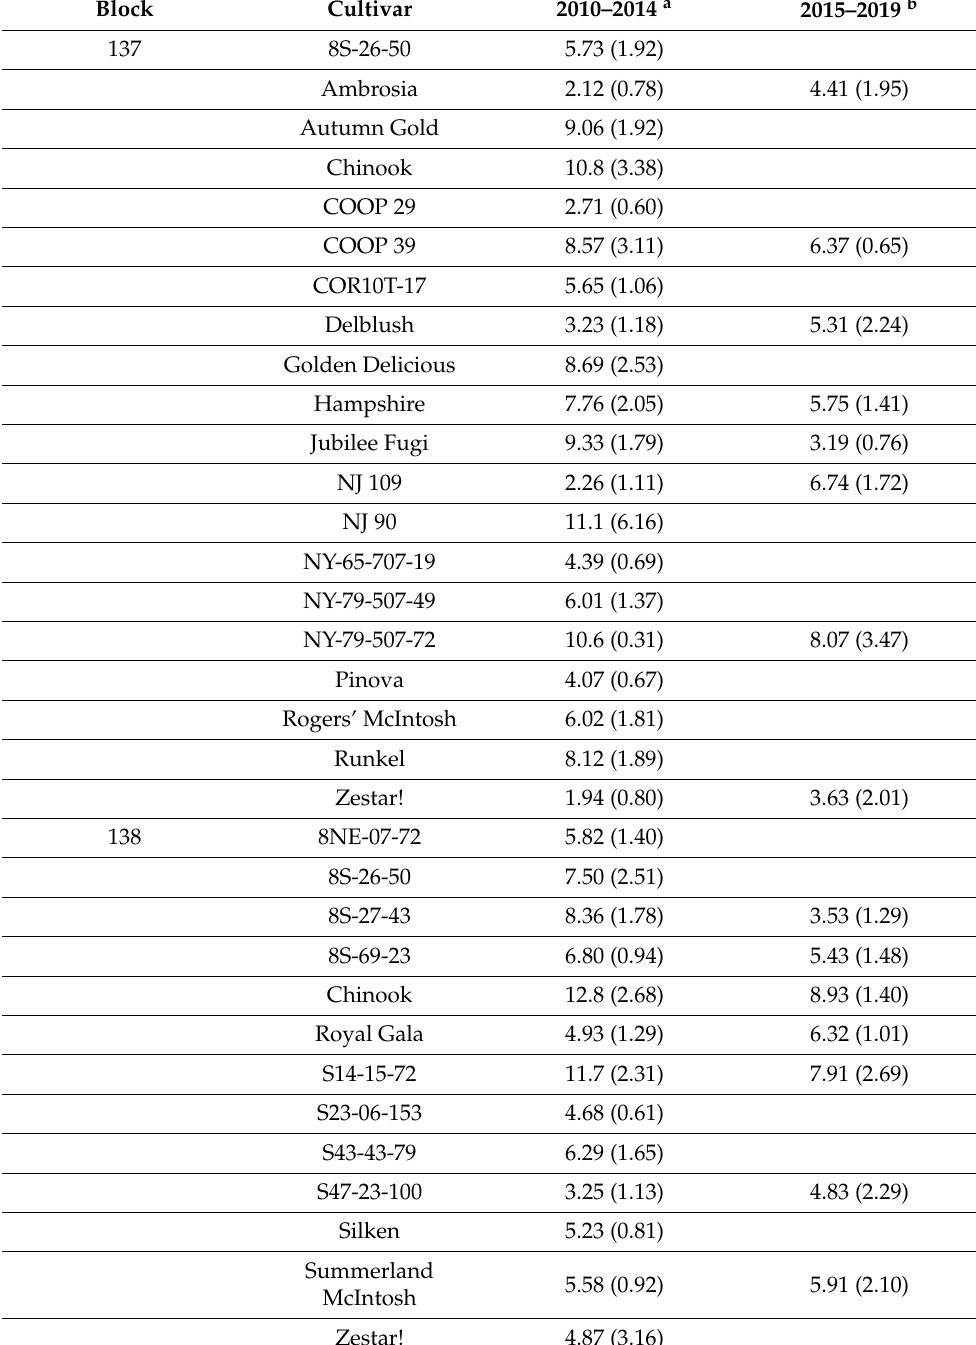
Table 1. Percentage ( ± SE) of apples showing damage from Hoplocampa testudinea on cultivars from 2 blocks located at the Kentville Research and Development Centre, for all cultivars from 2010–2014 and for a subset of the cultivars from